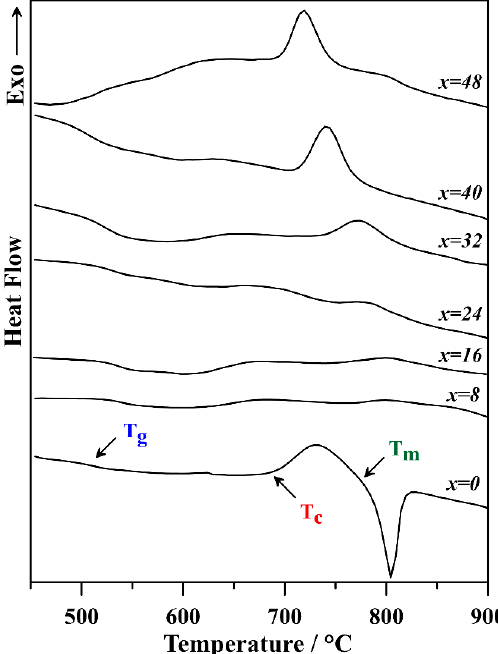
Figure 2. DTA curves from the glass series(100 − x)[0.4Na 2 O-0.2Nb 2 O 5 -0.4P 2 O 5 ]-xB 2 O 3 .